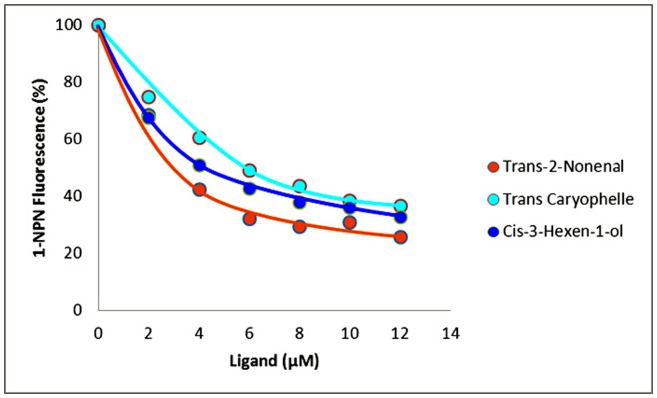
Three ligands binding curves.Affinities of selected odorants: trans-2-nonenal, cis-3-hexen-1-ol, and β-caryophelle to M. cingulum odorant-binding protein 1 (McinOBP1). The fluorescence intensities are plotted against increasing ligand concentrations.